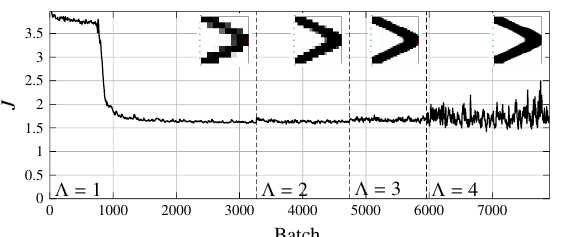
Figure 12. Progression of the objective function value during training. 𝑃 The dashed vertical lines (labeled with the value of Λ ) in Figures 12 and 13 indicate the change in level. It can be seen that the objective function value J improves significantly in the first level Λ and in the following levels only slightly. The reason for this is that learning in one level optimizes the resolution in subsequent levels as well. This is also the explanation for the fact that the objective function value hardly increases when a level is in- creased. A slight increase can nevertheless be seen, which is due to the increased resolution and thus, the higher number of evaluated elements and the increase in complexity. 0